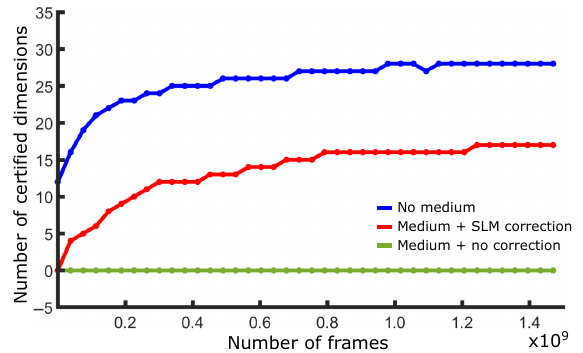
FIG. 4. The certified-dimension analysis. The number of certi- fied dimensions for different total numbers of frames without the medium (blue curve), with the medium and SLM correction (red curve), and with the medium and no correction (green